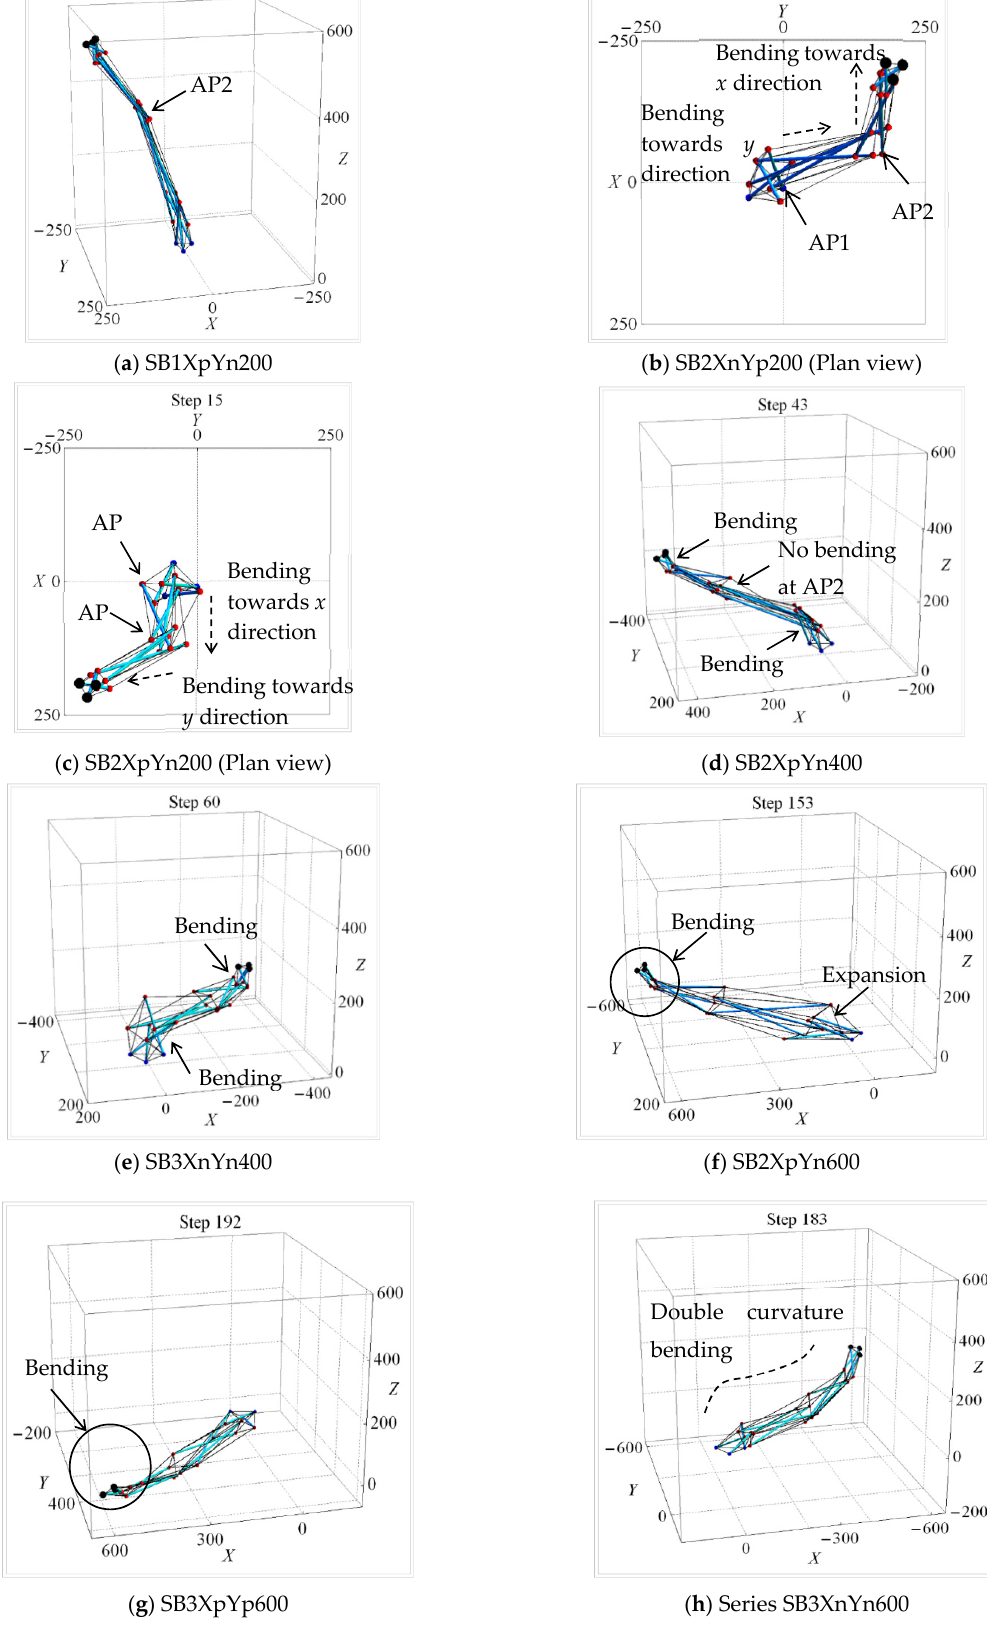
Figure 17. Deformed configuration ( a – h ) at the final step for cases with the bi ‐ directional mode. Figure 18 shows the final state for cases of shape change analysis involving the tri ‐ directional mode. SB models in series XY200Z reach their target coordinates mainly by means of bending deformation about AP1 and AP2 (Figure 18a). On the contrary, almost all SB models in series XY400Z reach the target coordinates by means of axial deformation (Figure 18b). In series Zp, all SB models in series XY200Zp and XY400Zp reach the target coordinates by means of axial deformation (Figure 18c,d). The vertical clearance between the two groups of nodes (the upper and lower nodes) becomes significant when both x and y or z target displacement magnitudes increase. On the other hand, all SB models in series XY200Zn reach the target coordinates pri ‐ marily by means of bending deformation. In cases with z target displacement magnitude of 200mm, all SB models in series XpYn and XnYn generally bend around AP2 whereas series XpYp and XnYp demonstrate noticeable bending around both AP1 and AP2. When the z target displacement magnitude increases, bending deformation around all apices, AP1, AP2 and AP3, is observed (Figure 18e). Bi ‐ axial bending is also observed in most of the cases (Figure 18f), except series XnYn, which shows only uni ‐ axial bending. Generally, the majority of all SB models in series XY400Zn show axial deformation with slight bend ‐ ing around AP3 in most of the cases with z ‐ displacement magnitude of 200 mm, while, for cases of magnitudes of target displacement equal to 400 mm and 600 mm, bending around AP1 and AP2 is generally seen. It is noted that all SB models demonstrate expan ‐ sion and contraction in the final configuration. The proposed spine model incorporates the freedom of movement inherent in humans but does not necessarily exhibit the same movements experienced by humans. Depending on the settings of the analysis model, it may show cases of shape change that exceed the limits of human spine movement, as shown in Figures 15–18. Nevertheless, the findings derived from the use of the simplified spine biotensegrity model considered in this study provide useful insight into the influ ‐ ence of the incorporation of human spine topology on the deformation characteristics of the model.